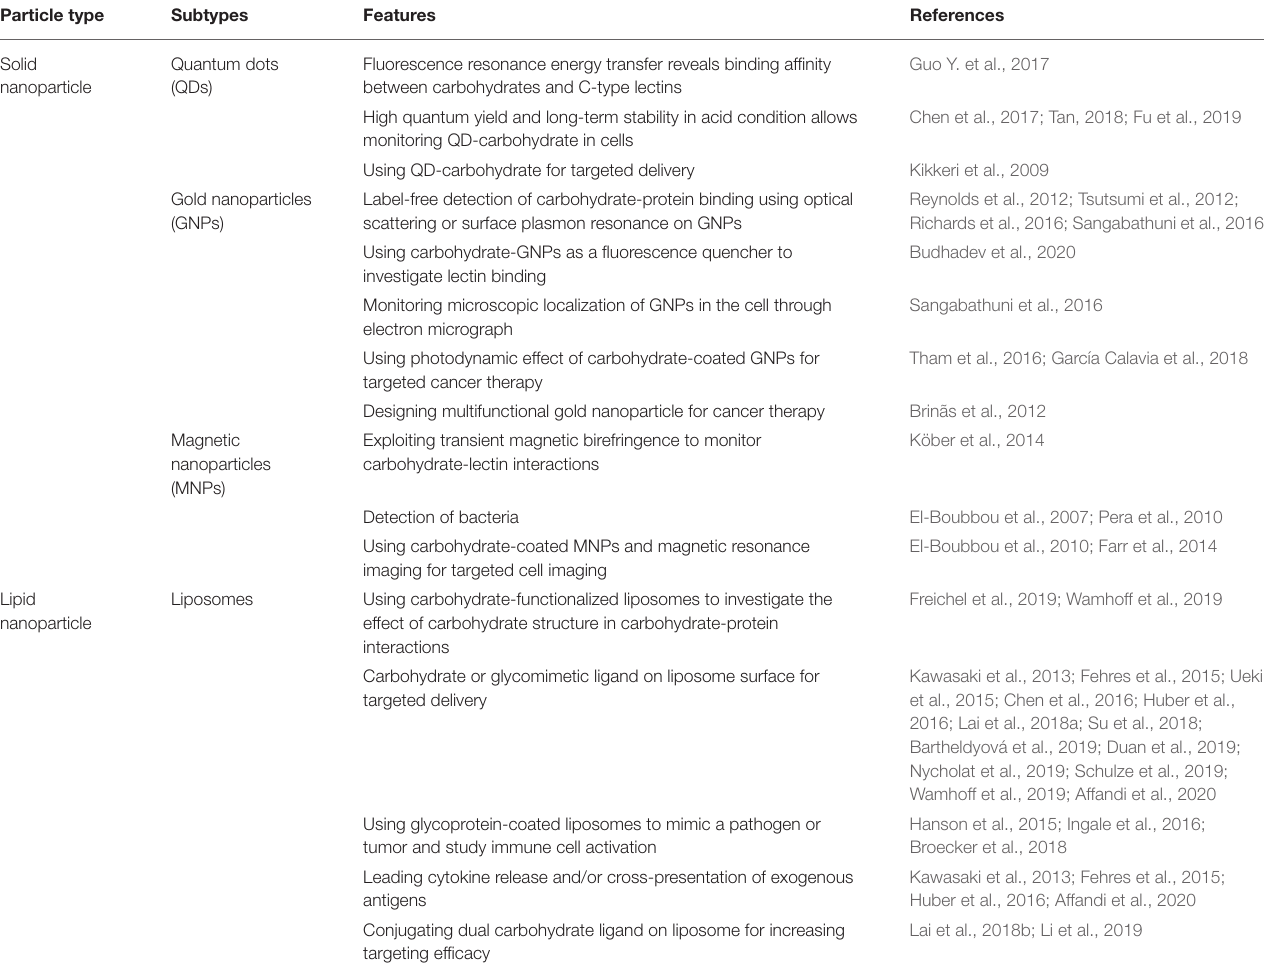
TABLE 1 | Classification of particles that have been used for probing carbohydrate-protein